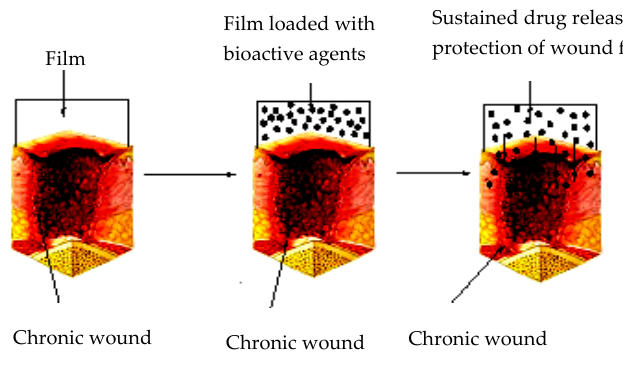
Figure 4. Films for wound dressing.